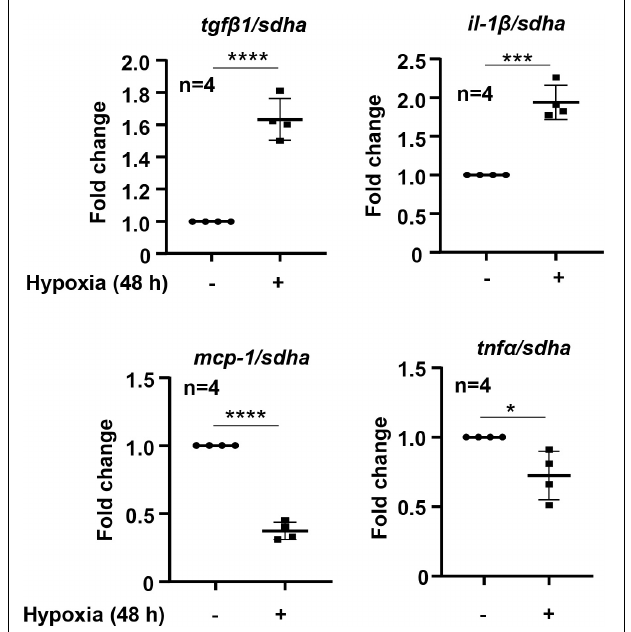
FIGURE 3 | Effects of hypoxia on cytokine expression in HK-2 cells. HK-2 cells were cultured under normoxia or hypoxia conditions for 48 h. The mRNA levels of tgf β 1, il-1 β , mcp-1, and tnf α were analyzed by qRT-PCR. Data are showed as mean ± SD. * P < 0.05, *** P < 0.001, **** P < 0.0001 between the indicated groups. Un-paired Student’s t -test was